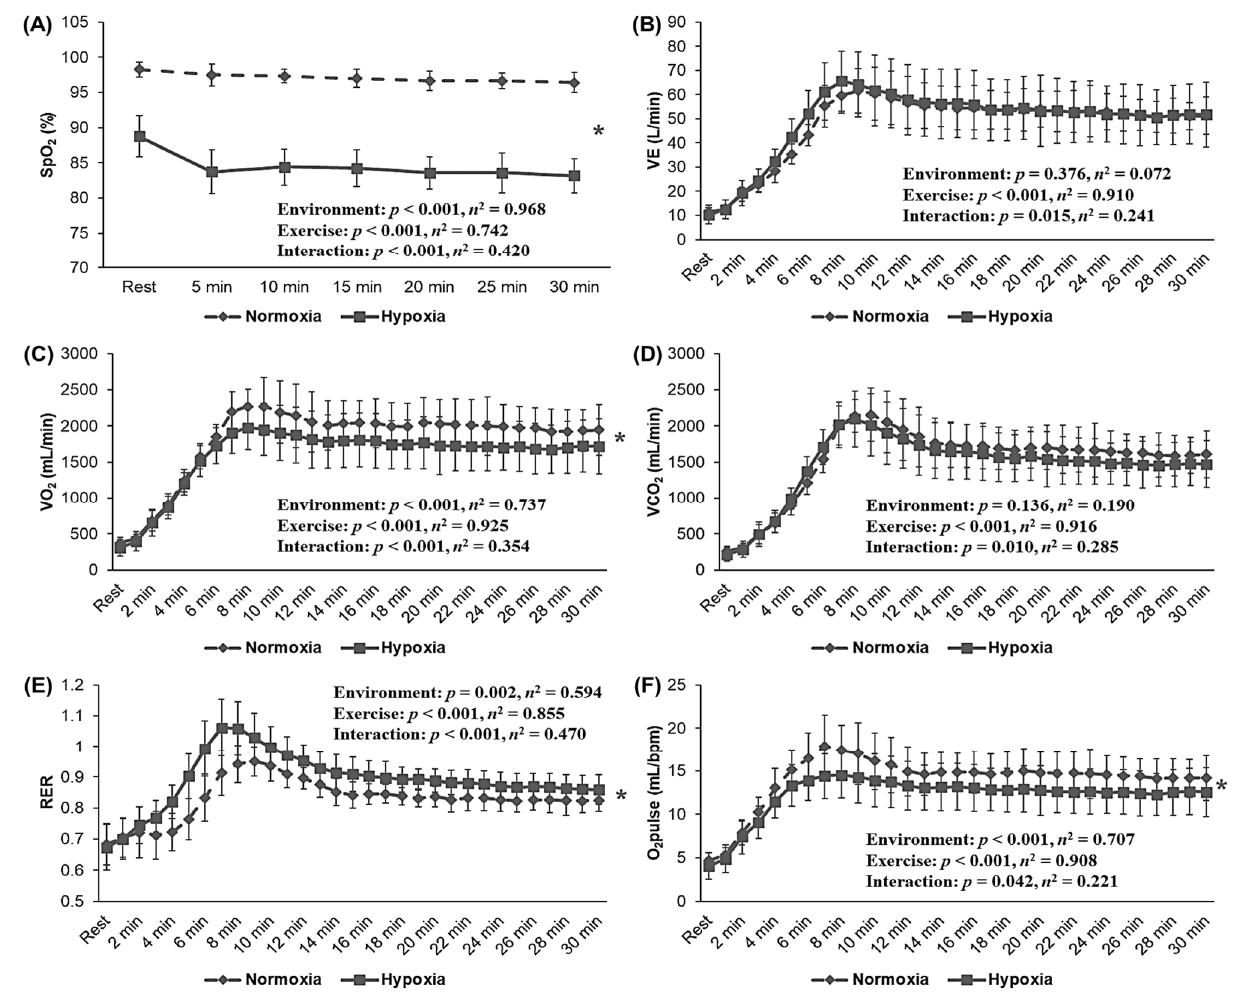
Figure 4. Changes in metabolic function during 30 min of the endurance exercise at the same HR level ( 136.5 ± 1.5 bpm) under normoxia (760 mmHg) and hypoxia (526 mmHg, simulated 3000 m). ( A ) SpO 2 , ( B ) VE, ( C ) VO 2 , ( D ) VCO 2 , ( E ) RER, ( F ) O 2 pulse. HRmax: maximal heart rate; SpO 2 : saturation of percutaneous oxygen; VE: minute ventilation; VO 2 : oxygen uptake; VCO 2 : carbon dioxide excretion; RER: respiratory exchange ratio, O 2 pulse: oxygen pulse. The bars indicate the mean ± S.D. *: Significant difference within the environmental condition (normoxia vs. hypoxia) during 30 min of the endurance exercise.